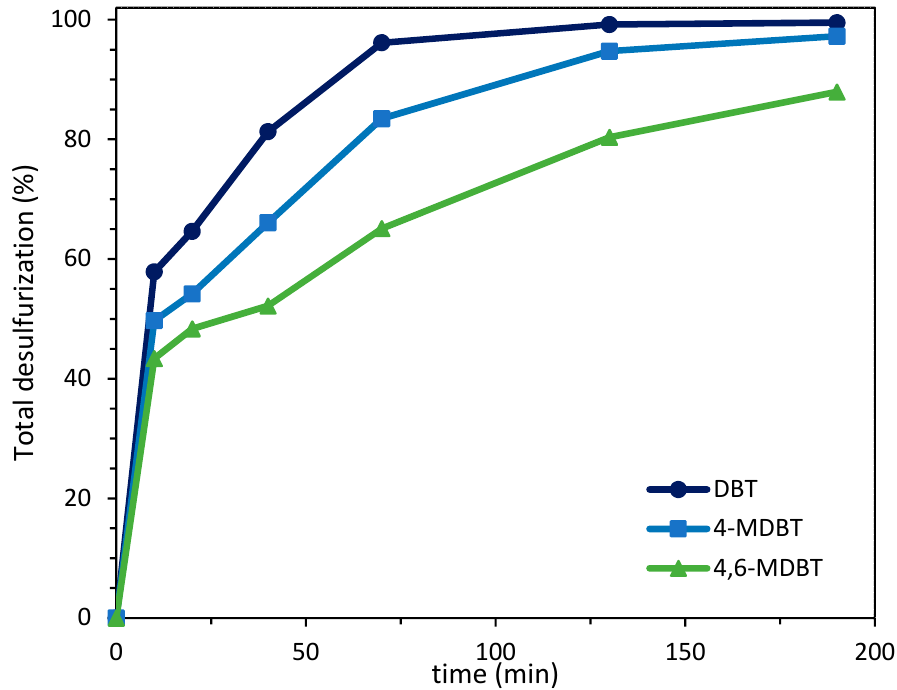
Figure 5. Desulfurization profile for the individual sulfur components present in the multicomponent model fuel (DBT, 4-MDBT, 4,6-DMDBT) catalyzed by the heterogeneous EuW 10 @ZIF-8 (containing 3 µ mol of EuW 10 active center) using [BMIM]PF 6 as extraction solvent and H 2 O 2 as oxidant, at 70 °C.